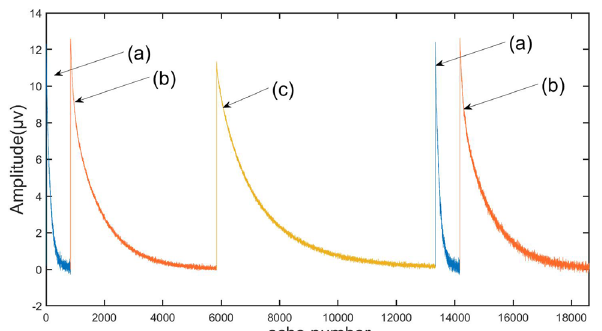
Figure 10. The data points of effective echo trains obtained from three different samples are measured continuously. When testing sample a, the data obtained by the detection sequence determines that the T 2max of the sample is 10 ms through inversion, and the main control unit quickly adjusts the pulse sequence, and the length of the pulse train is reduced from the original value of 2 s to 50 ms. When testing sample b, the sample T 2max was determined by inversion to be 100 ms, and the pulse sequence was adjusted to a CPMG sequence with 5000 echoes. When testing sample c, the pulse sequence remained unchanged due to the larger T 2max .